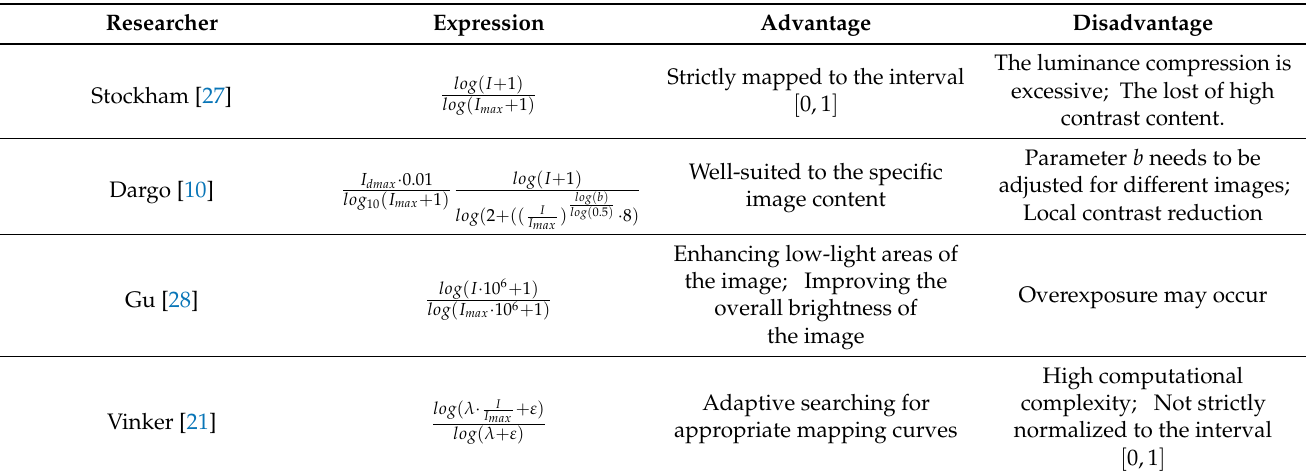
Figure 2. Mapping curves with different p values. Table 1. Summary of tone mapping preprocessing